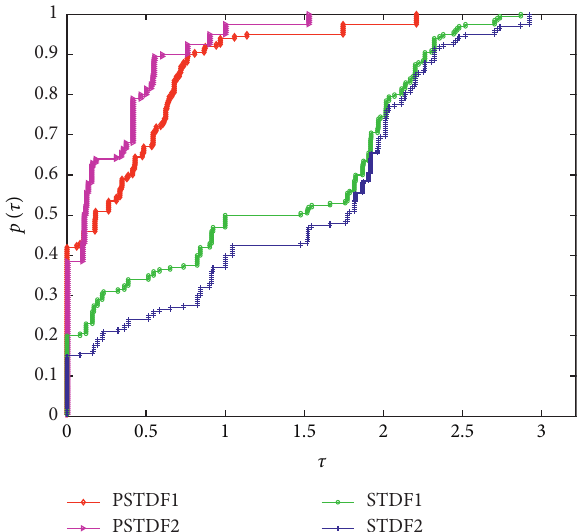
Figure 2: Performance profiles for the number of function evaluations (NFE).